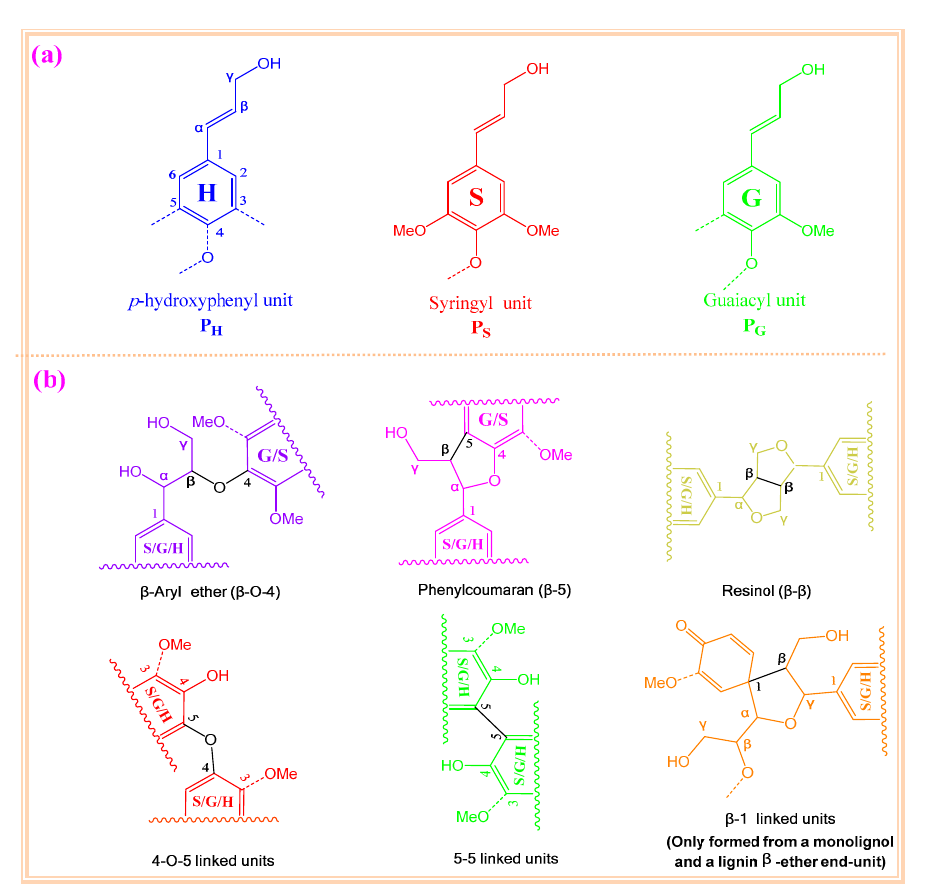
Figure 1. ( a ) Structures of three typical monomers of lignin and ( b ) their bonding types.